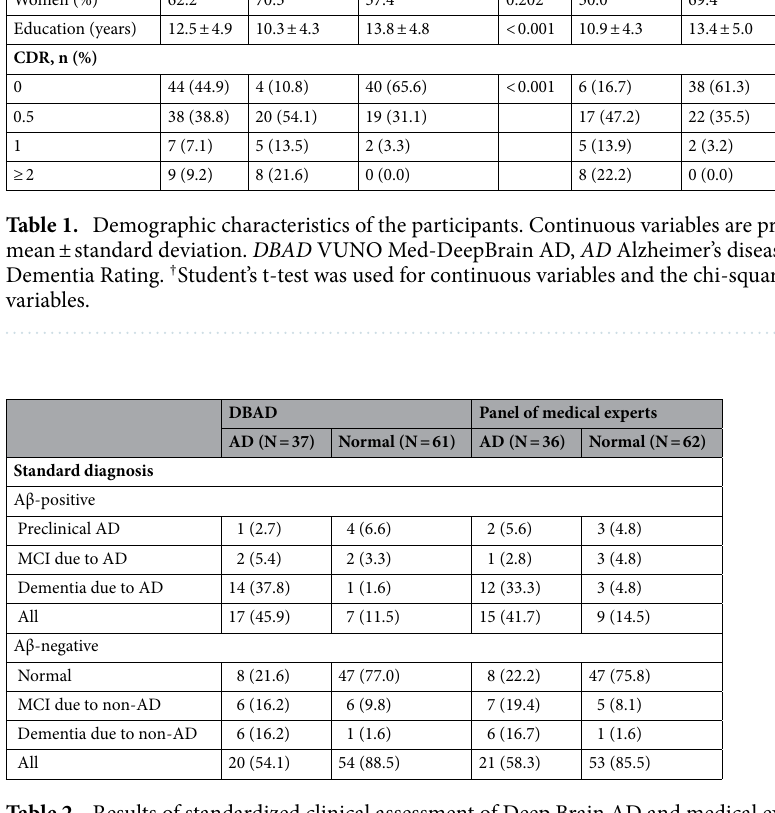
Table 2. Results of standardized clinical assessment of Deep Brain AD and medical experts. DBAD VUNO Med-DeepBrain AD, AD Alzheimer’s disease, MCI mild cognitive impairment. Number of cases with percentage in parenthesis.